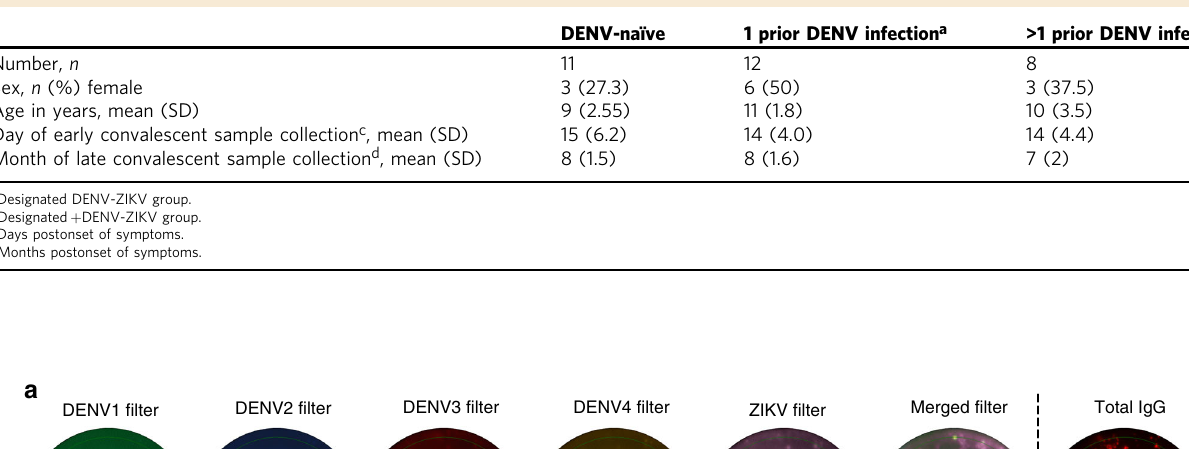
Table 1 Characteristics of ZIKV-infected patients